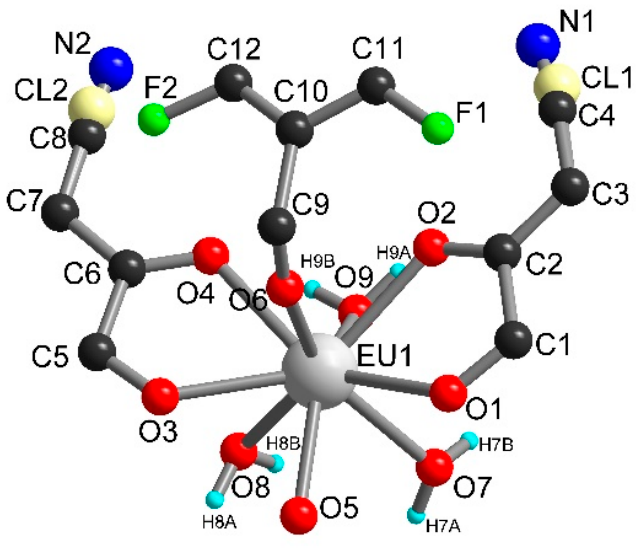
Figure 4. Asymmetric unit in 3 .